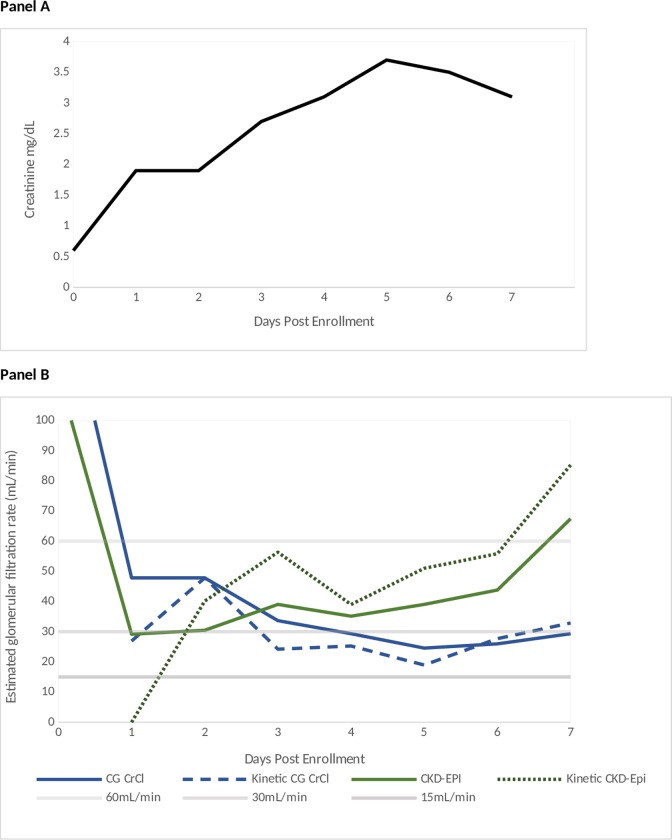
Sample application of kinetic estimate.Panel A illustrates the creatinine trajectory of one participant with AKI within the first 7 study days; Panel B illustrates the corresponding calculated CG CrCl and CKD-EPI eGFRs and their corresponding kinetic estimates. Horizontal lines in the figure demarcate FDA dosing categories (e.g., 15, 30, and 60mL/min). After the rapid creatinine rise during the development of severe AKI, the kinetic CG CrCl fell to within the 15–30mL/min dosing category on Day 1, while the CG CrCl dosing category was 30–60mL/min. This subject would be considered to have discordant drug dosing categories on this day. Conversely, on Day 7, the kinetic estimate is higher than the CG CrCl because of the lag in SCr decline during renal recovery. Using the CKD-EPI equation, discordant drug dosing categories only occurred on Day 1. On other study days, drug dosing categories were concordant.